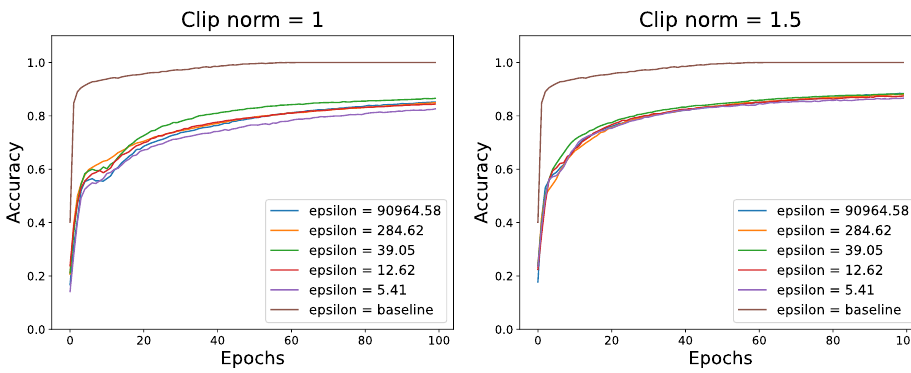
Figure 21. DP model training process. Table 2. Test accuracies in different gradient clipping and